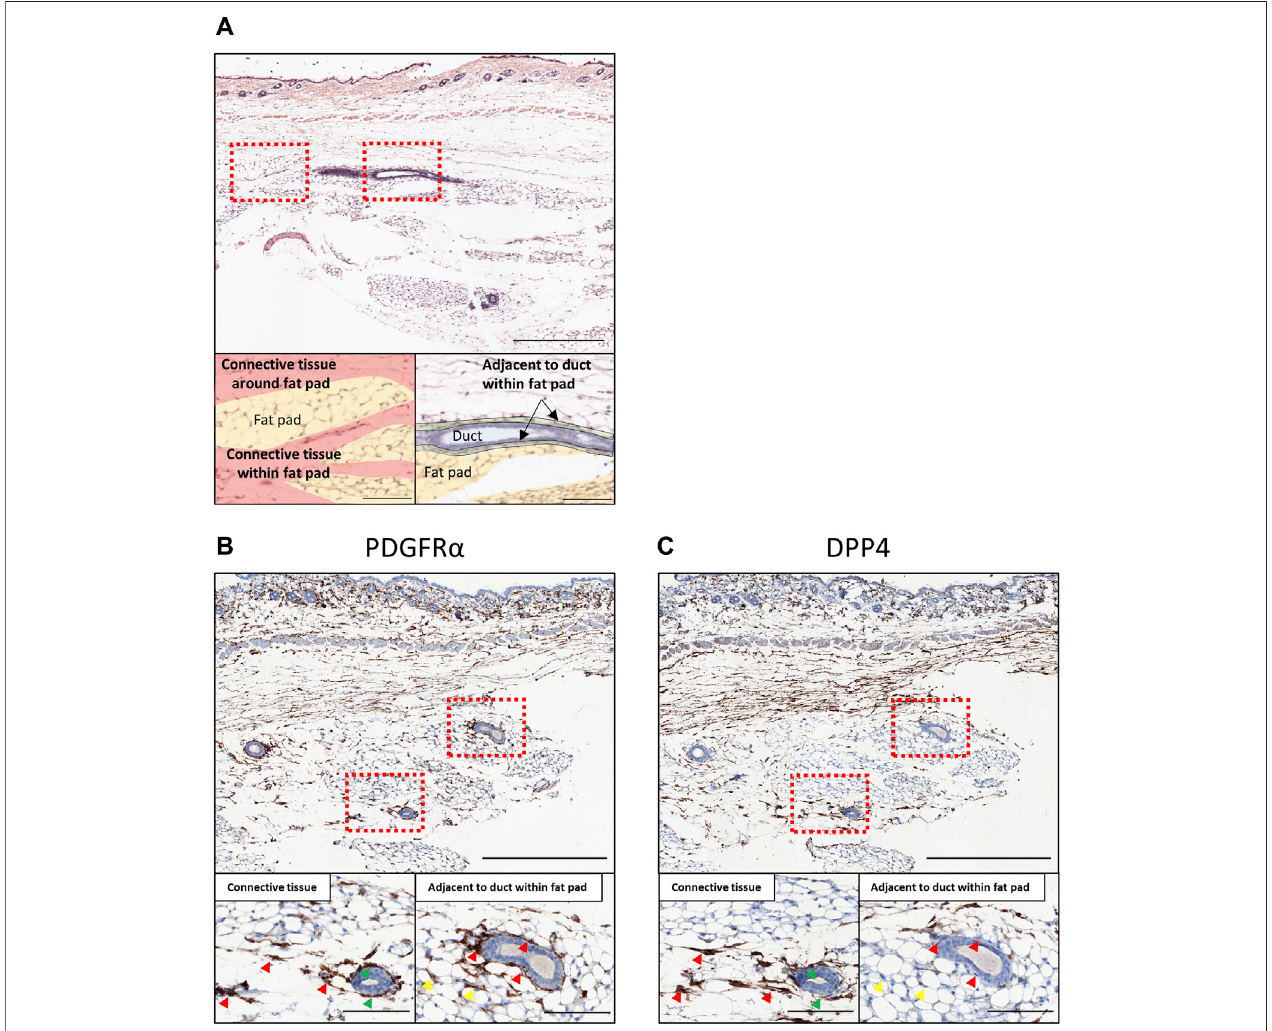
FIGURE 3 | Histological evaluation in normal mouse mammary gland tissues. (A) The H&E staining of the normal mouse mammary gland. The bottom panels are coloredaccordingtohistologicalannotationasindicated. (B,C) Theimmunohistochemicalstainingofnormalmousemammaryglandfor (B) PDGFR α and (C) DPP4.The mammary glands of eight-week-old C57BL/6J mice were collected together with skin (at the top part of the images) and cross-sectioned. The upper panels show the entire images of the mammary glands at low magni fi cations. The lower panels show the magni fi ed images of the boxed area for the connective tissue region around/within the mammary fat pad (left) and theregionadjacenttomammaryglandducts within thefat pad (right). Red arrowheads indicate the representative staining patternof each fi broblast type for each target. Green arrowheads indicate the representative cells ofPDGFR α + /DPP4 + around the mammary gland ducts going through the connective tissue region. Yellow arrowheads indicate the representative cells among the adipose tissue for each target. Scale bar = 500 μ m (upper) and 100 μ m (lower).